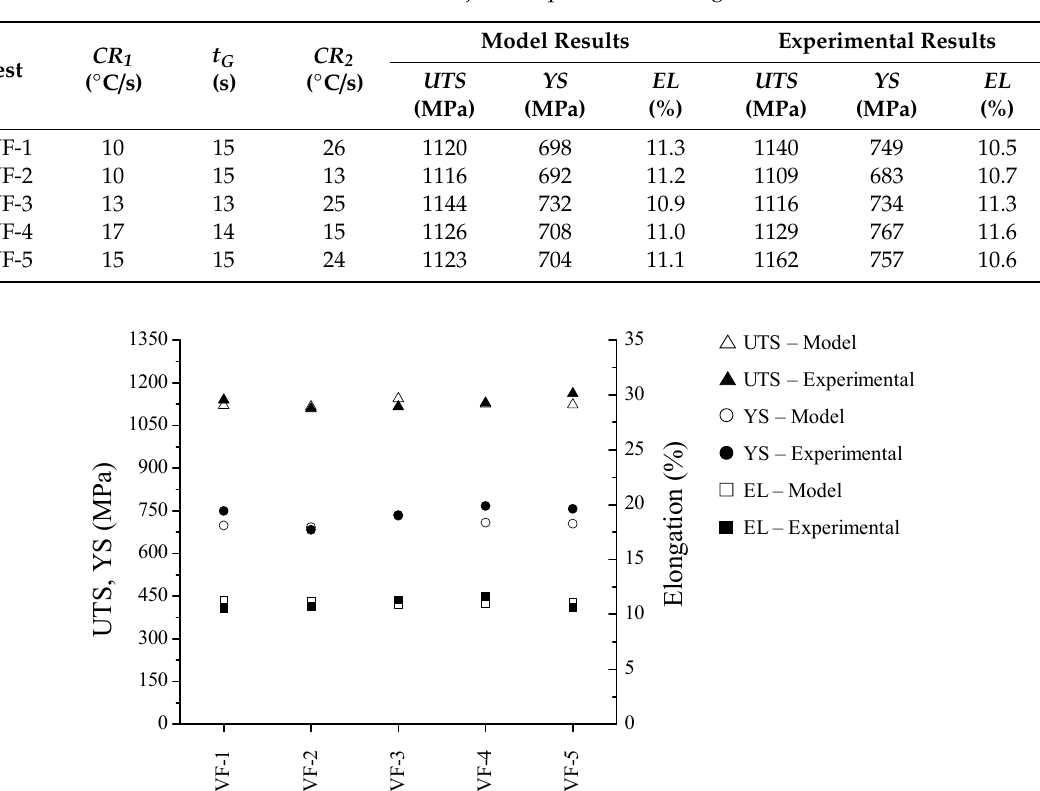
( b ) Figure 6. Microstructure of TVF ‐ 3 heat treated sample: ( a ) 2,500× and ( b ) 10,000×; B: Cainite; α : Ferrite and α ’: Martensite. 3.4. Effects of Process Parameters In the manufacturing of galvanizing DP ‐ AHSS steels, the cooling rate ( CR 1 ) must be fast enough to avoid the formation of perlite or bainite and retain carbon in solution in the metastable austenite until the transformation to martensite takes place at T < M s . With the statistical models developed in this work (Equations (6)–(8)) it is possible to predict the effect of CR 1 over the mechanical properties to DP steel, as shown in Figure 7. To plot this graph, the secondary cooling rate ( CR 2 ) was kept